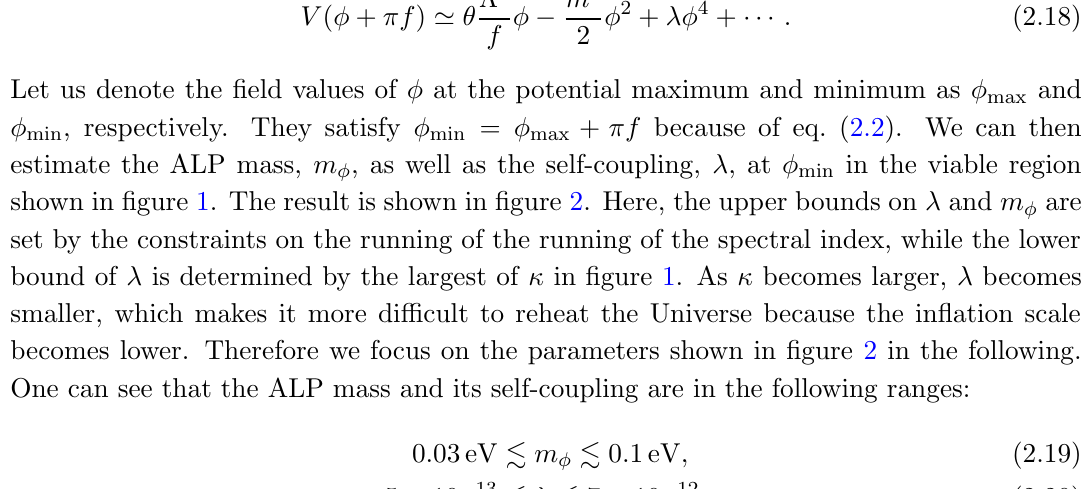
JHEP02(2018)104